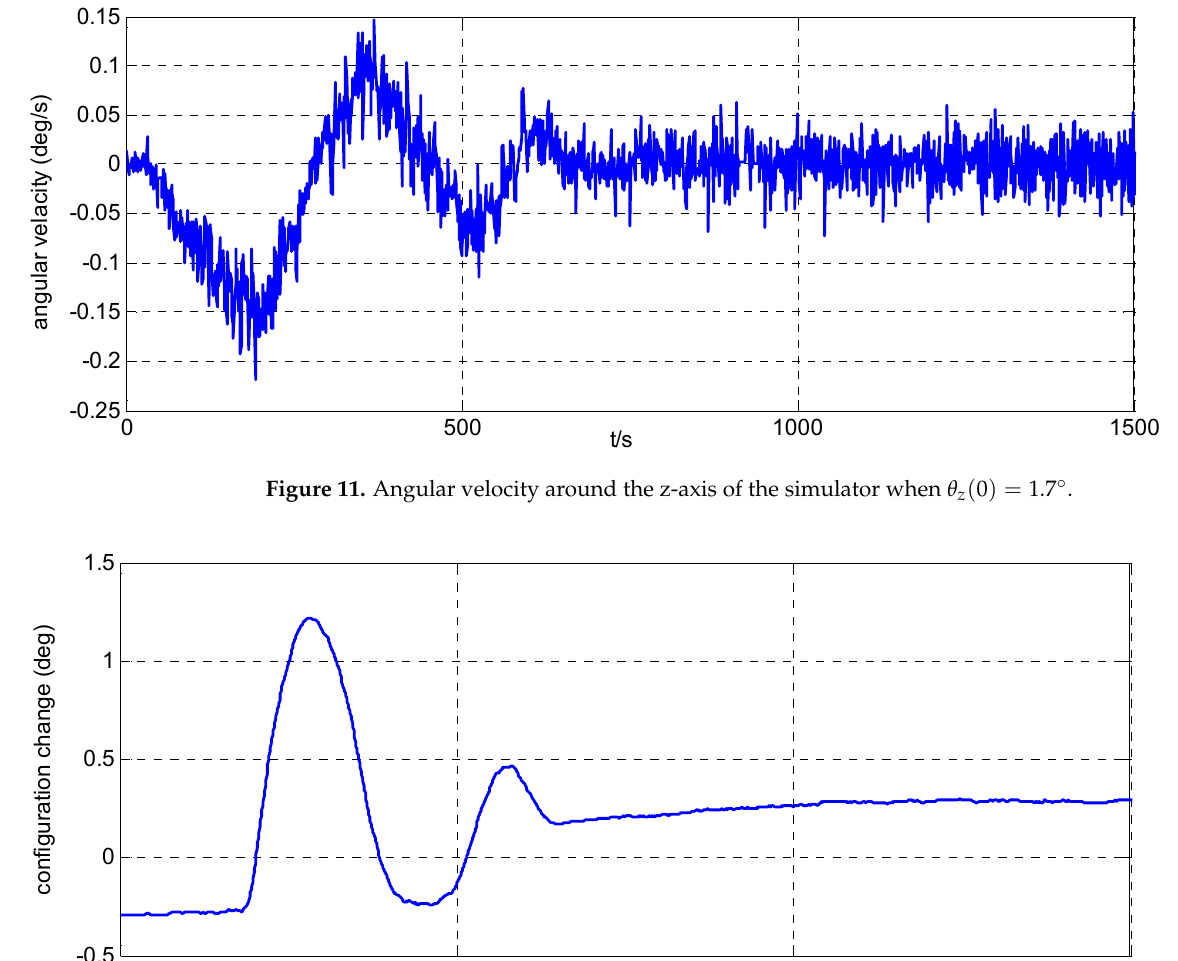
Figure 10. Angle around the z-axis of the simulator when